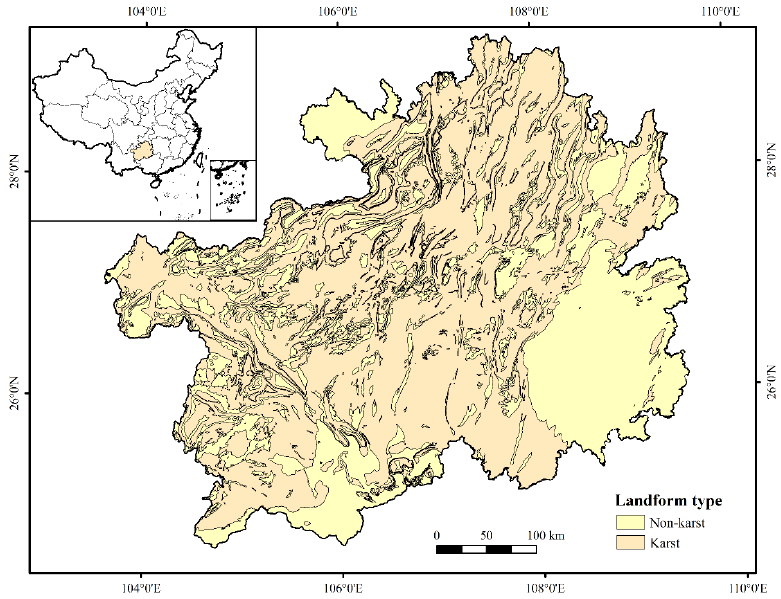
Figure 1. Location and landform type of the study area. Karst landforms—dominated by limestone, dolomite, and other carbonates—account for more than 70% of the total area in the province [25]. In past decades, degradation of vegetation and ecosystems occurred worldwide, including stony desertification. Since 2000, the GOC has invested 13 billion yuan to control stony desertification and vegetation degradation, minimizing the influence of human activities on the ecosystem via ecological migration and other measures. However, ecological restoration is marked by spatial differences owing to the complexity of the local geological conditions and